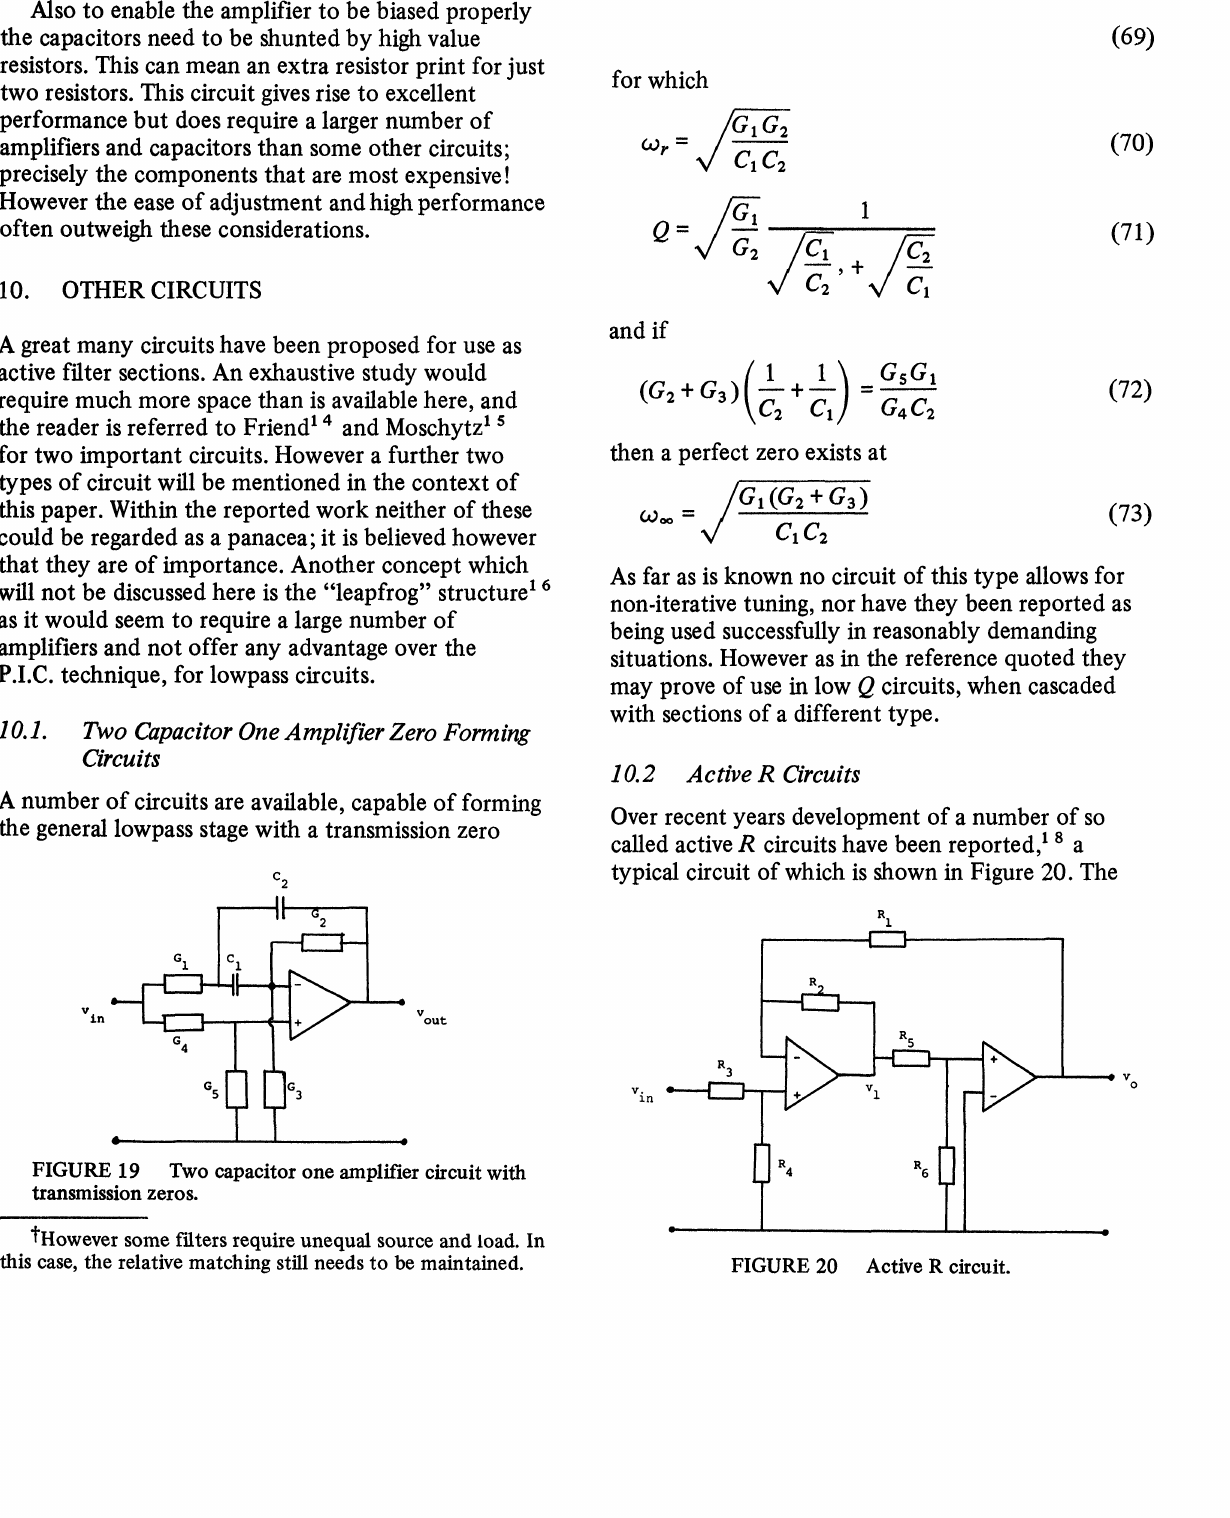
Two capacitor one amplifier circuit with transmission zeros.